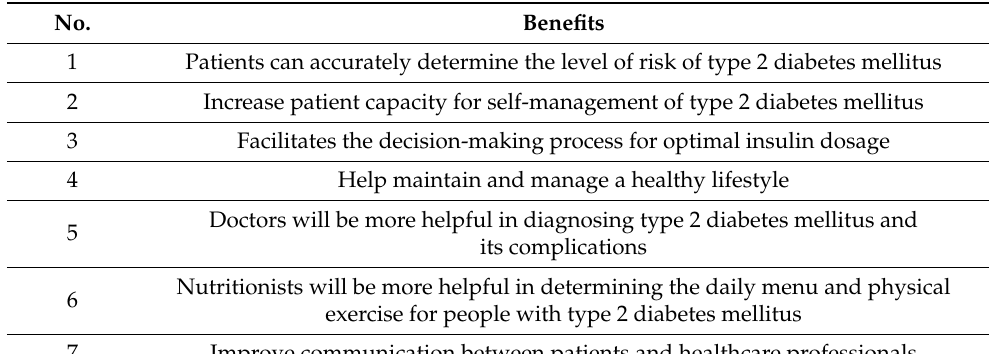
Table 8. Potential Benefits of the Application.